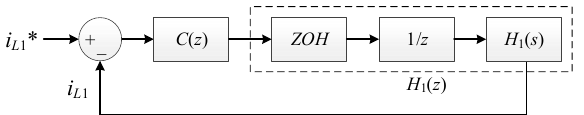
Figure 17. The block diagram of the control loop.